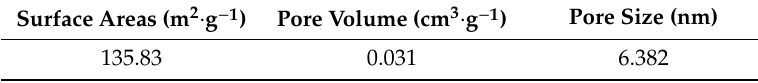
Table 2. Specific surface areas, pore volume, and pore size of rice husk char.